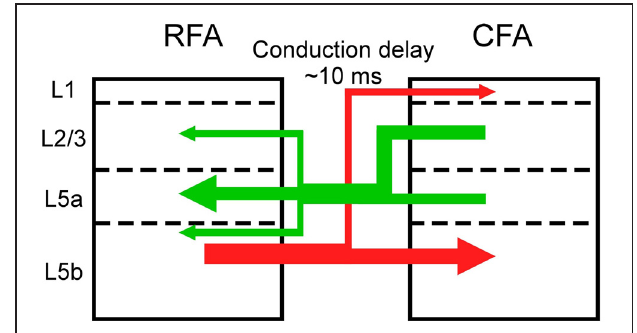
FIGURE 7 | Asymmetric synaptic connectivity between the RFA and the CFA. The RFA receives stronger functional projections from L2/3 and/or L5a of the CFA than from L5b of the CFA (green). The CFA receives stronger functional projections from L5b of the RFA than from L2/3 and L5a of the